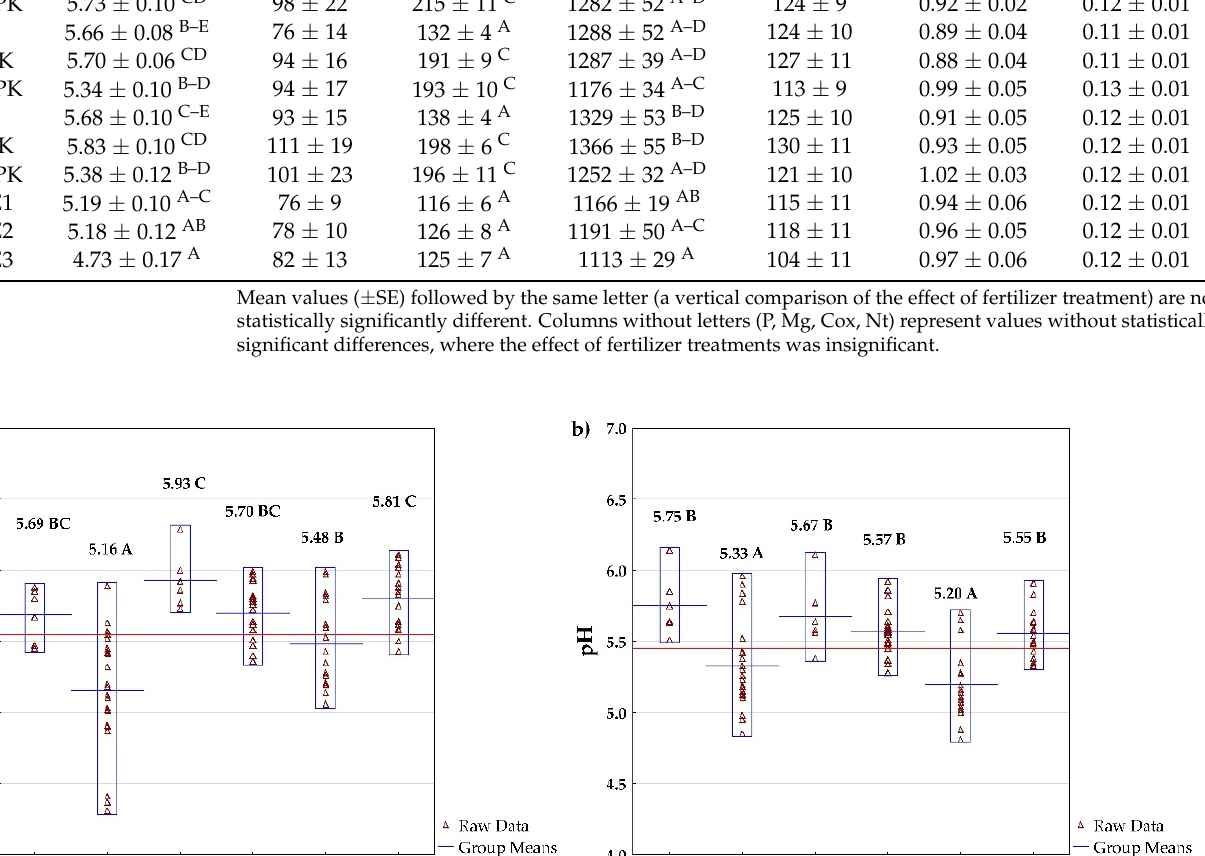
lowest mean pH values were recorded in treatments with mineral N – NPK (5.33) and